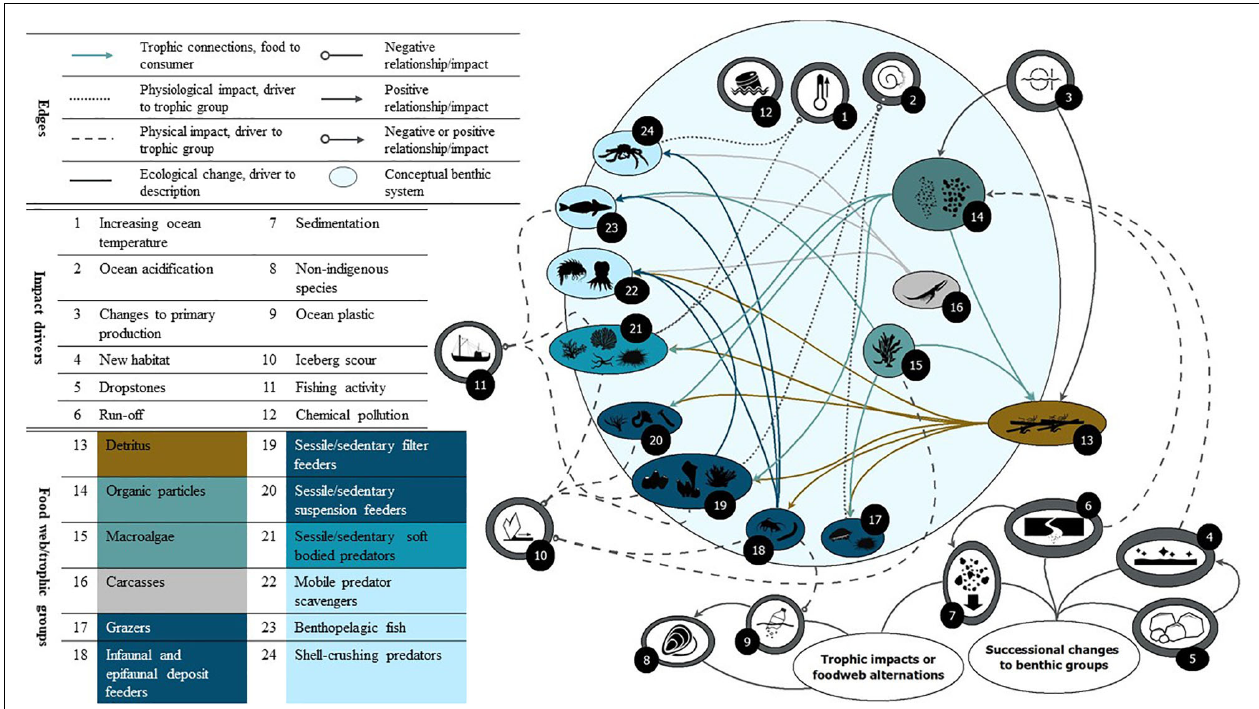
FIGURE 8 | Conceptual network diagram demonstrating multiple impact drivers acting on benthic functional groups within the Southern Ocean. Colored arrows indicate trophic connections in prey color, gray arrows indicate driver relationships. Refer to Figure 1 of this article for driver pathways. Functional groups adapted from Barnes and Sands (2017) and listed in the Supplementary Information . Note that impact drivers within the conceptual benthic system circle could impact the physiology of all functional groups depending on rate or level of change but only the most sensitive groups are indicated by connecting dashed lines.